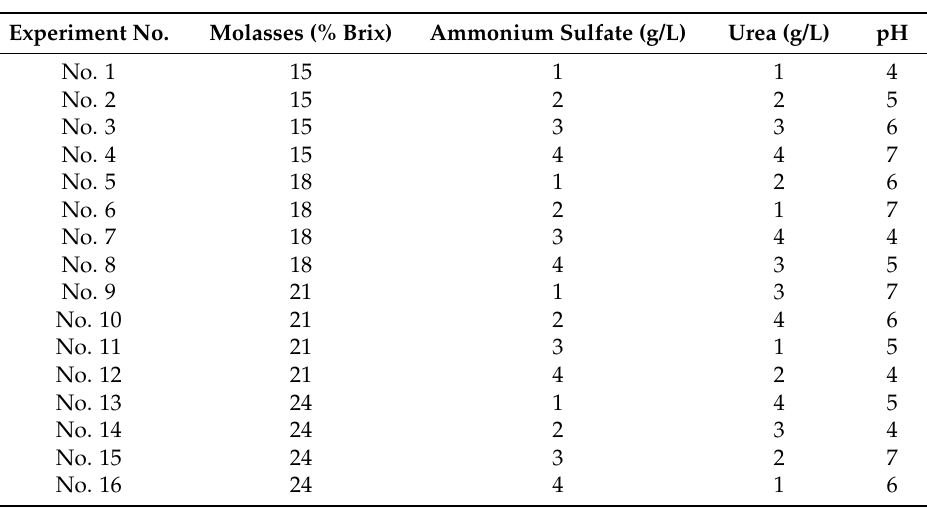
Table 2. Recommended experiments by the Qualitek-4 software. Experiment